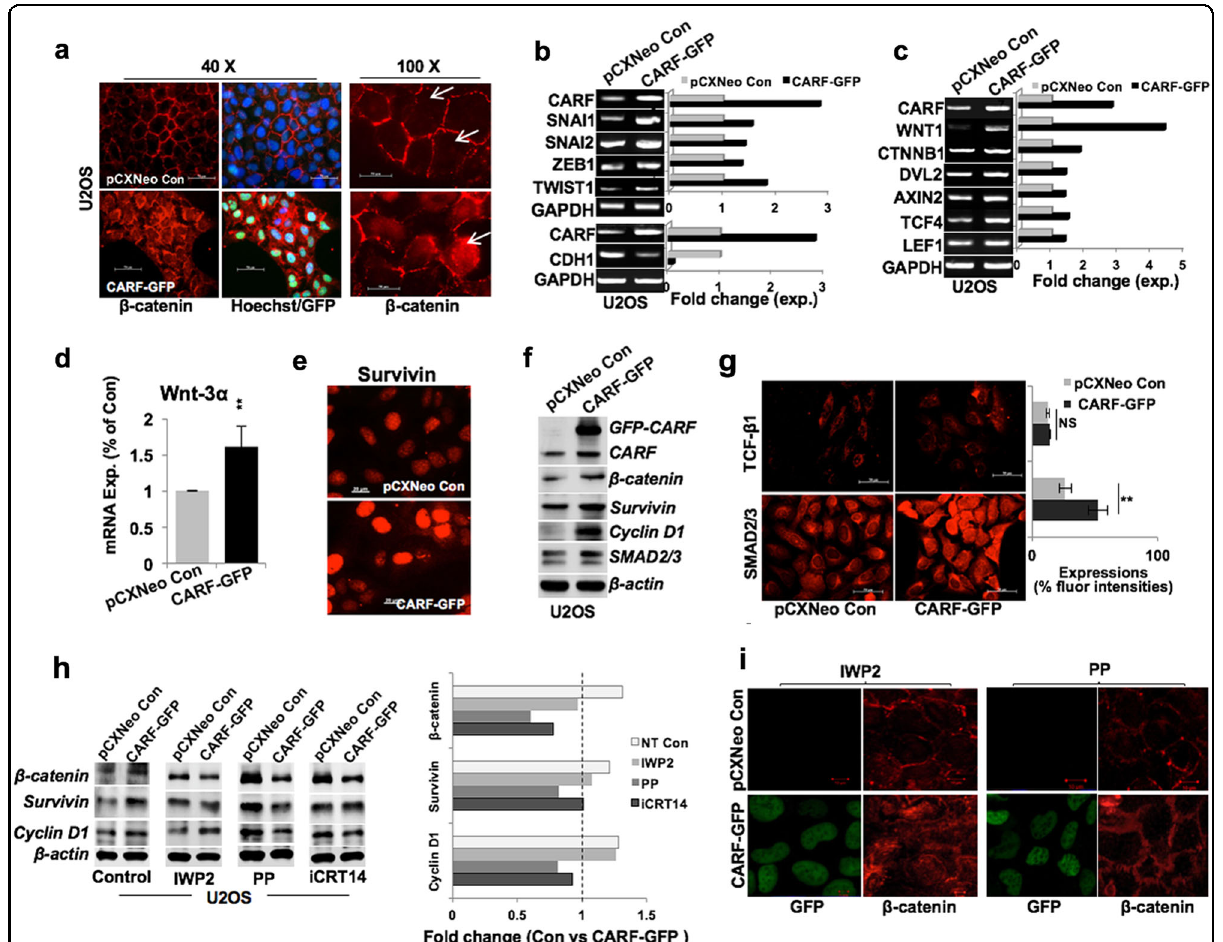
Fig. 4 CARF enrichment promoted EMT via activating Wnt/ β -catenin signaling. a Immunostaining showing β -catenin expression in control and CARF-enriched cells; nuclear enrichment of β -catenin is clearly seen in the latter in image on the right (×100, marked by arrow). b mRNA expression of transcription factors (SNAIL1, SNAIL2, ZEB1, TWIST1, and CDH1) in control and CARF-enriched cells. c Transcript levels of β -catenin target genes (WNT1, CTNBB1, DVL2, AXIN2, TCF4, and LEF1); quantitation (fold change) is shown on the right. d qPCR-based mRNA quantitation showing increased Wnt3 α in CARF-enriched cells. e Immunostaining showing survivin expression. f Immunoblots showing increase in β -catenin and its target proteins viz. survivin, cyclin D1, and SMAD2/3 in CARF-GFP cells. g TCF- β 1 and SMAD2/3 immunostaining showing an increase in latter, quantitation shown on right. h Immunoblots showing protein levels of β -catenin and its targets (Survivin, Cyclin D1) in control, IWP2-, PP- and iCRT14-treated control (U2OS pCXNeo), and CARF-enriched (CARF-GFP) cells, quantitation is shown on right. i β -catenin immuno fl uorescence in IWP2- and PP-treated cells; lack of nuclear β -catenin was observed in PP-treated